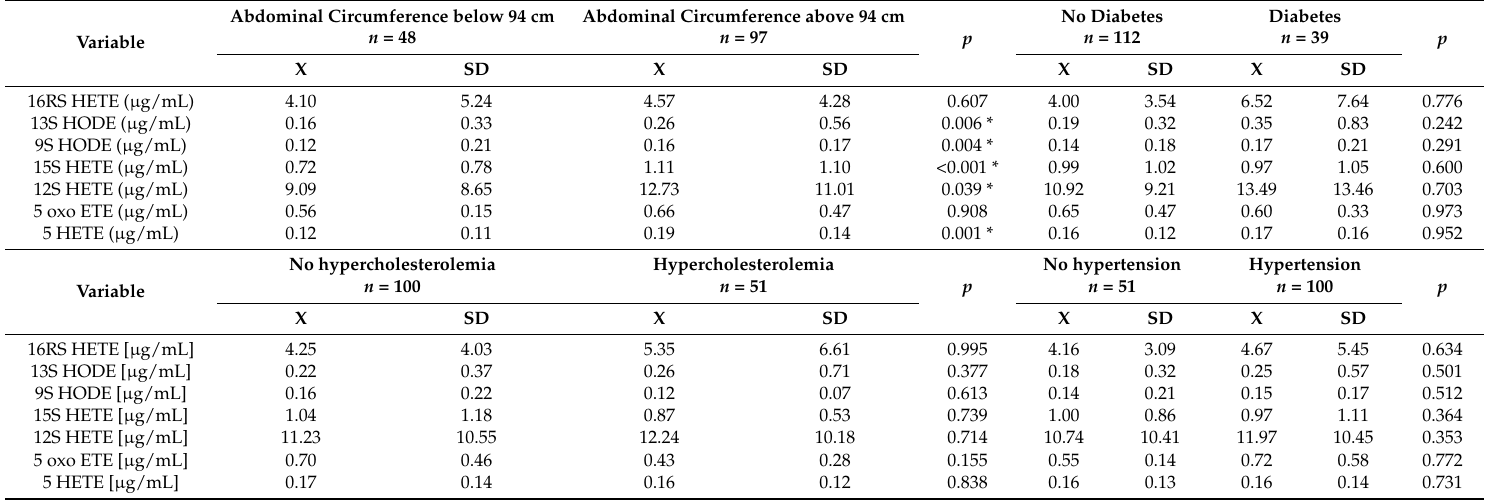
Table 2. The relationship between abnormalities diagnosed in the course of MetS and the levels of fatty